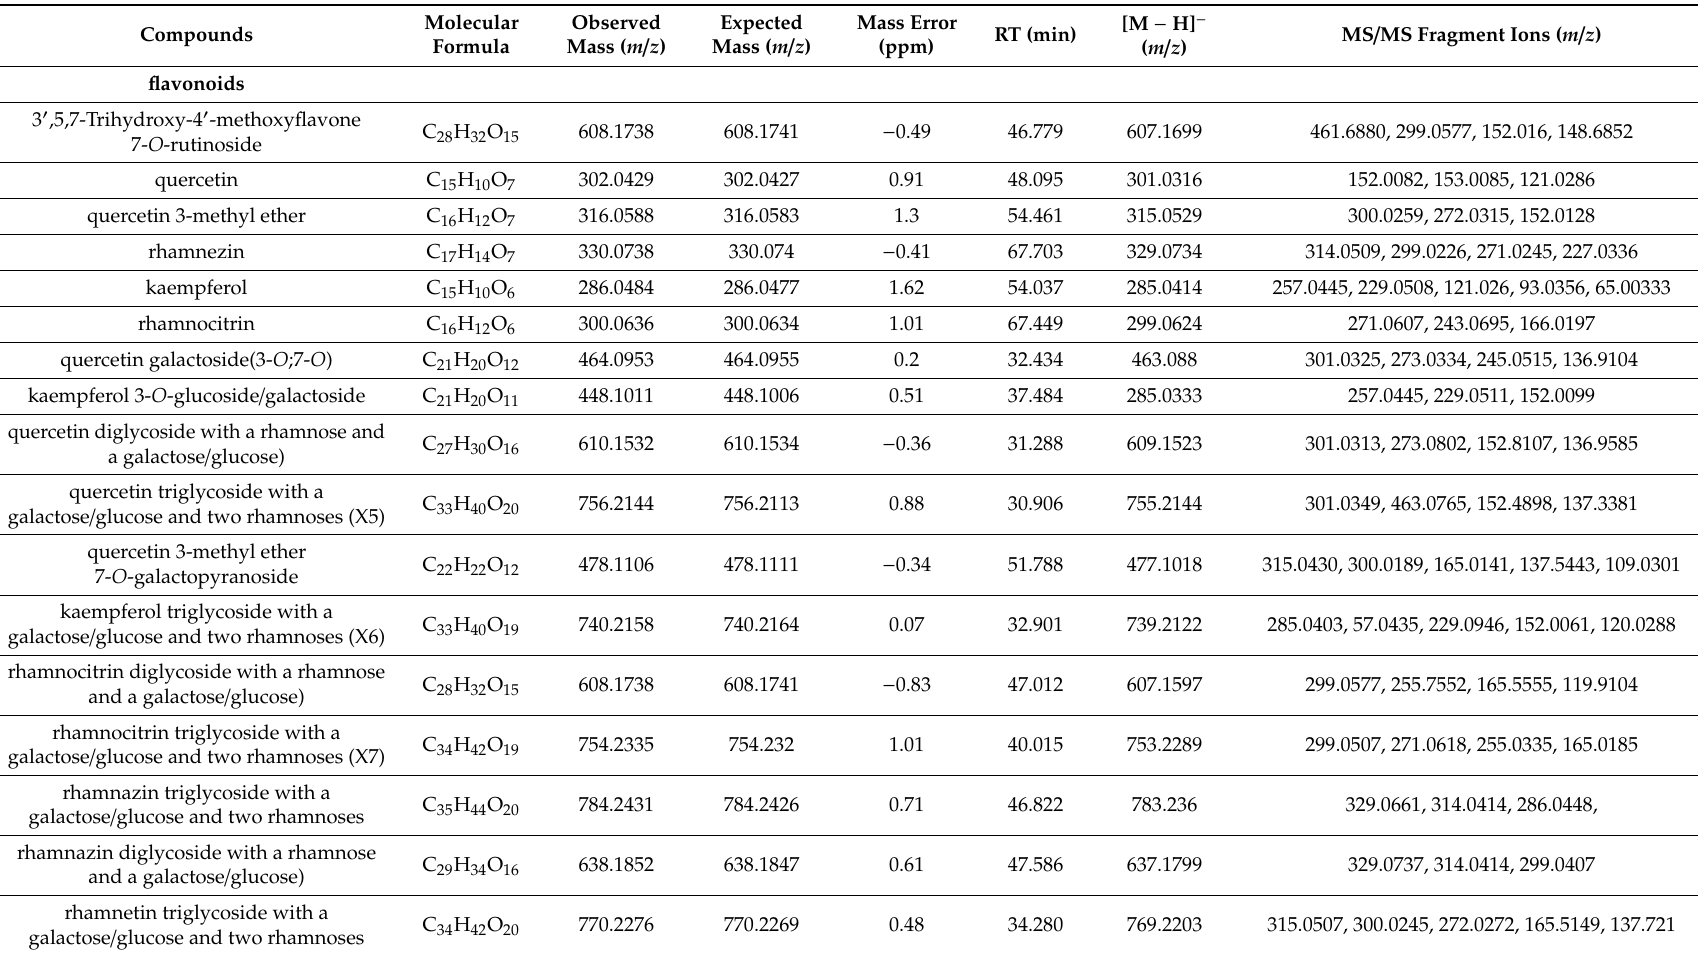
Table 4. The compounds identified by HPLC-DAD-ESI-MS /